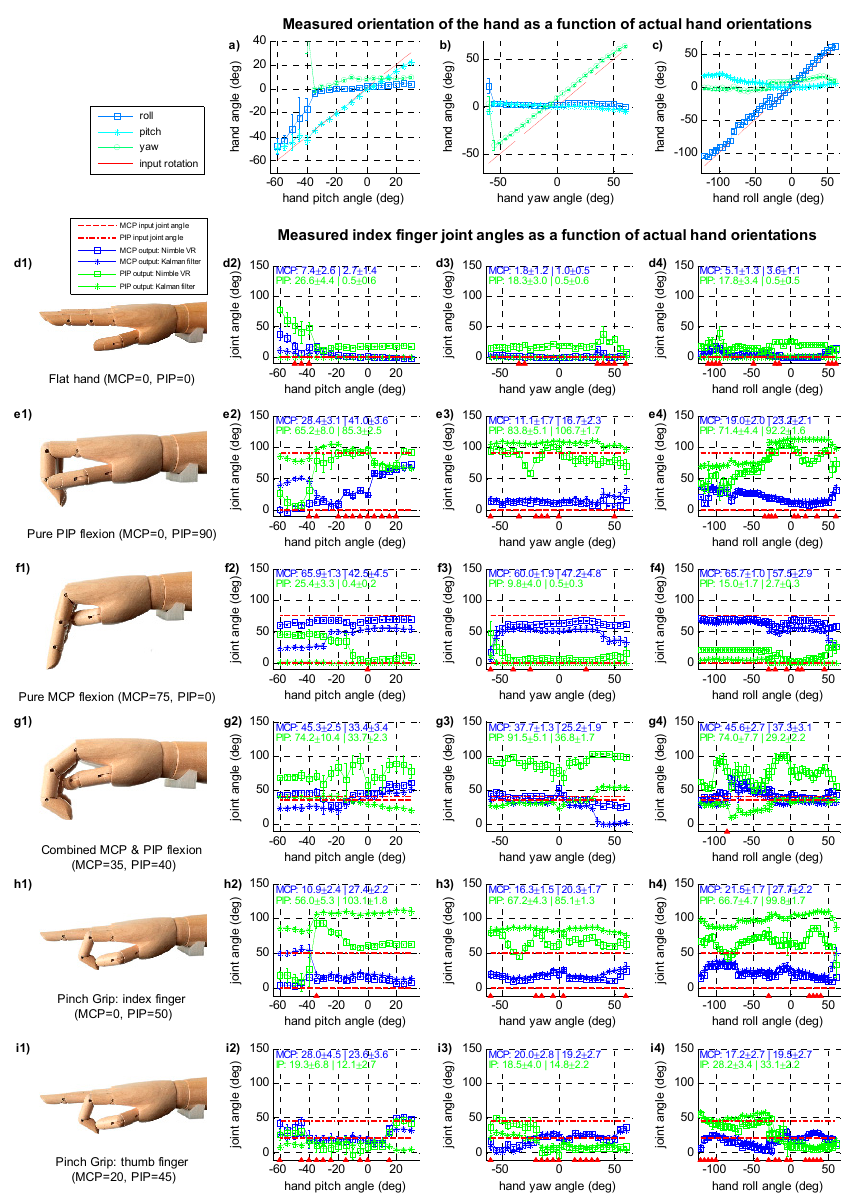
Figure 2. ( a–c ) Three plots providing measured orientation of the wooden hand model for varying actual hand orientations ( i.e. , pitch, yaw, and roll), indicated by red dashed unity lines; ( d1–i1 ) Photos of the measured hand orientations; ( d2–i4 ) Plots showing the measured metacarpophalangeal joint (MCP, blue) and proximal interphalangeal (PIP, green) joint angles, as determined with the Nimble VR system (square markers, ˝ ) and after fusion of the Data Glove data through the application of the Kalman filter (asterisk markers, *). Data is presented with error bars ranging from mean – 1 ¨ SD to mean + 1 ¨ SD. The actual angles at which the fingers were placed are indicated with the red dotted and dash-dotted lines, and are illustrated in the photos provided on the left. All plots show data collected on the index finger, unless otherwise specified below the photo on the left. Indicated in the top left of every graph are the mean and standard deviation (format: mean ˘ SD | mean ˘ SD) calculated over the entire hand orientation range before (left) and after implementation of the Kalman filter (right), for both joints. Note that these mean and standard deviations are calculated as the mean of the mean, and the mean of the standard deviations, calculated per 5 deg step. The triangle markers on the horizontal axes indicate whether the difference in mean PIP joint angle between Nimble NR and the Kalman filter is not statistically significant (note: MCP joint is not visualised in this